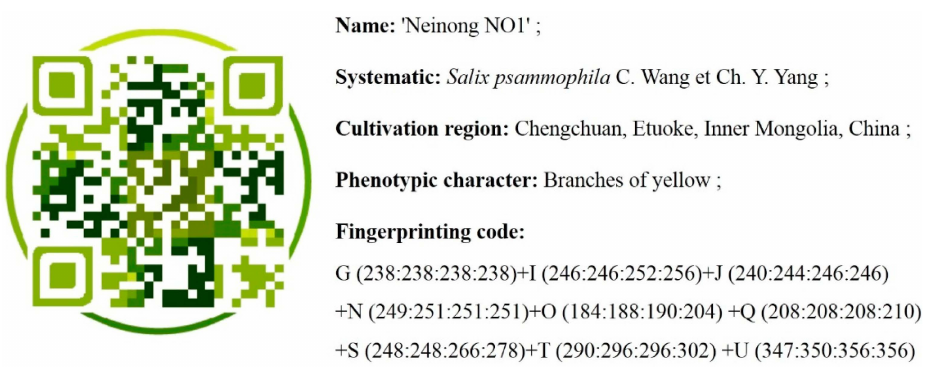
Figure 4. Two-dimensional barcode of S. psammophila ’Neinong